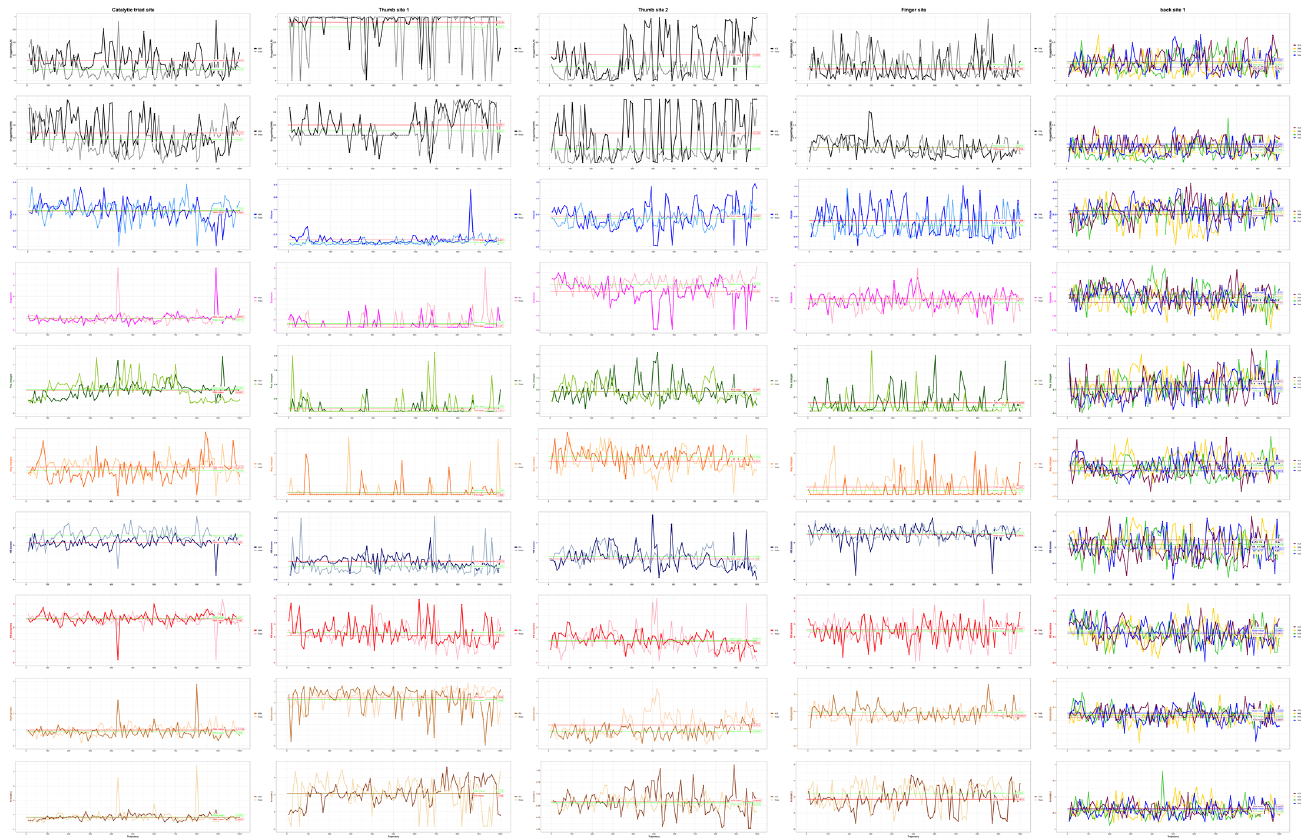
Figure 6. Physicochemical properties of the pocket along the MD trajectory. From left to right are the catalytic triad site, thumb site 1, thumb site 2, finger site, and back site 1.